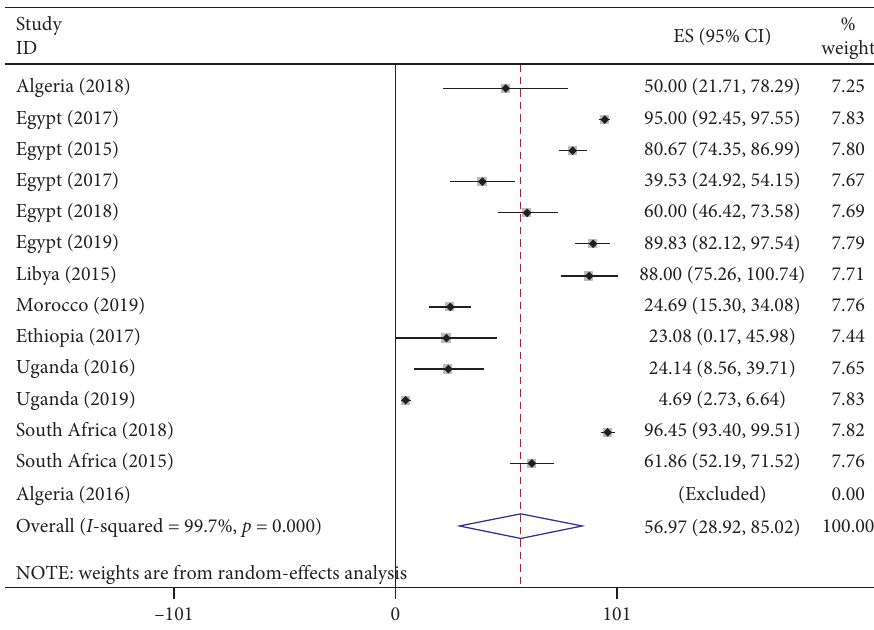
Figure 9: Forest plot for the pooled prevalence of CPAB isolates in Africa from 2007 to 2017 G.C.